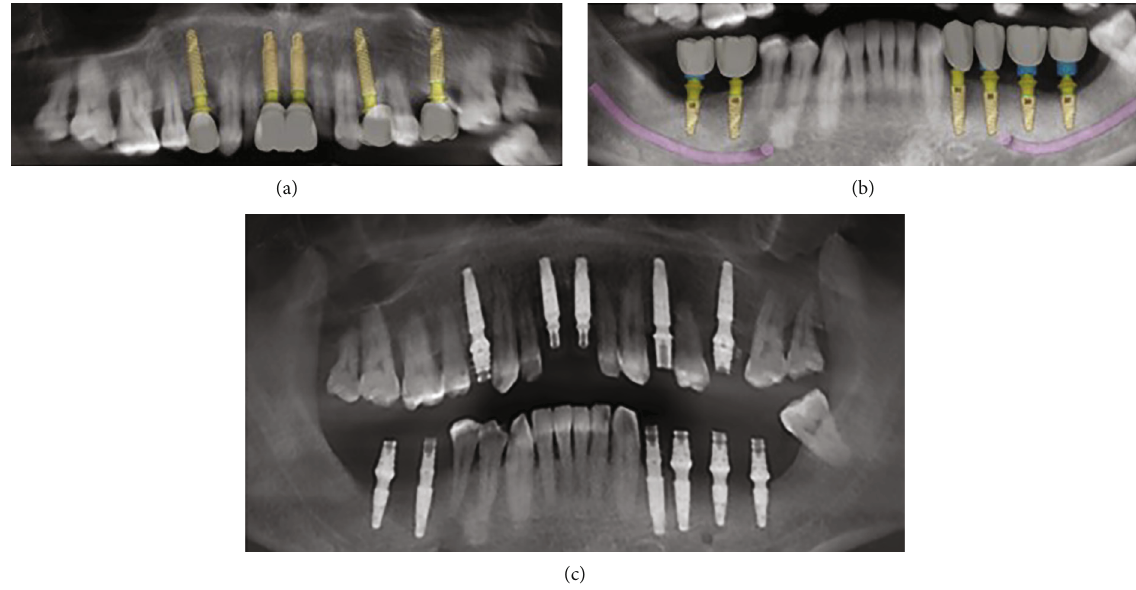
Figure 5: Virtual planning of implants and abutments (a, b) and immediate loading panoramic radiography